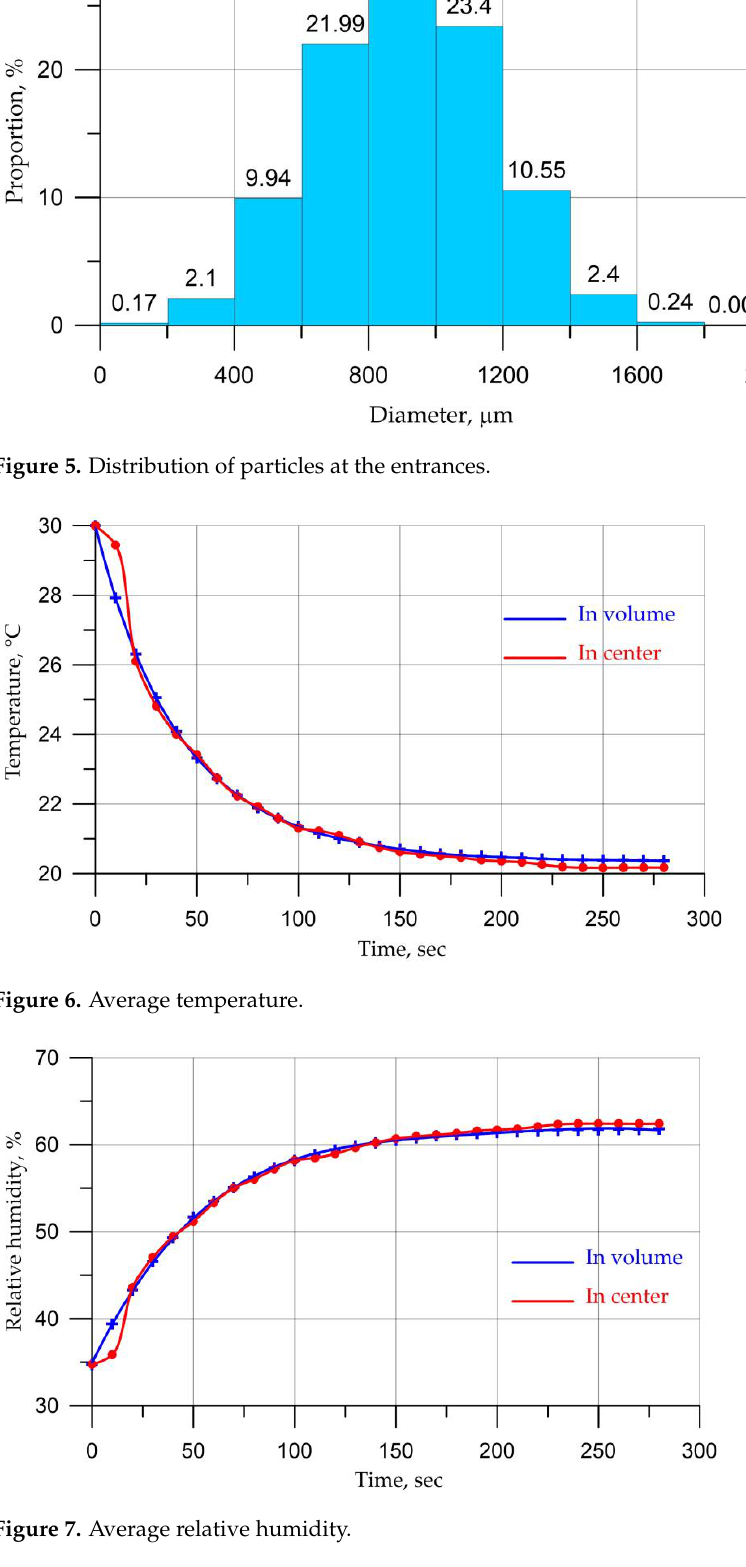
Figure 5. Distribution of particles at the entrances.